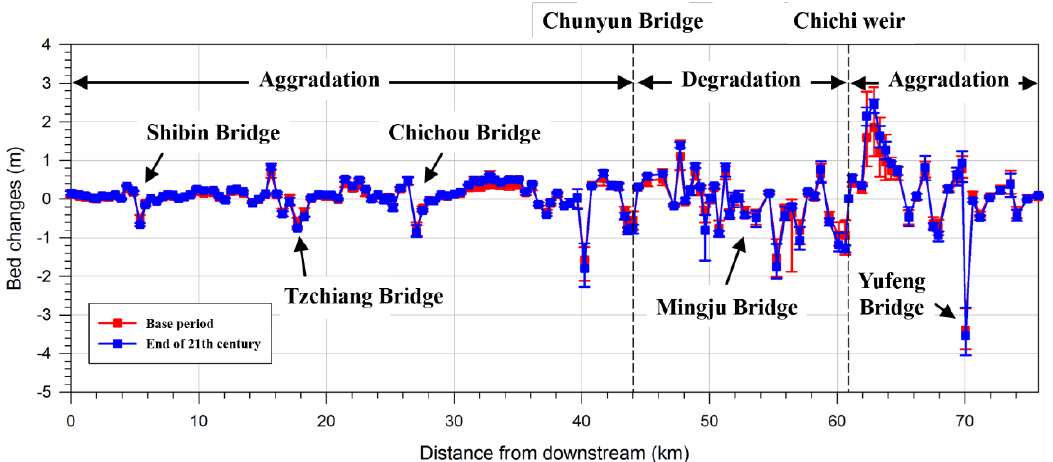
Figure 6. Changes in erosion and aggradation of the riverbed in the Choshui River under climate change scenarios.